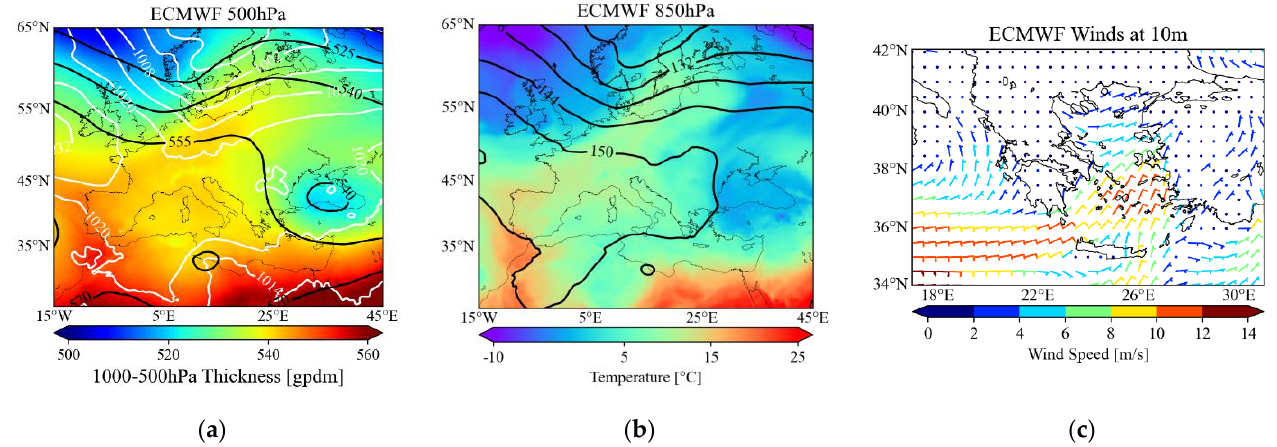
Figure 5. ECMWF Reanalysis Data for 10 April 2017, 06:00 UTC ( a ) 500 hPa Geopotential Height (black lines), MSLP (white lines), 1000 – 500 hPa Thickness, ( b ) 850 hPa Geopotential Height (black lines), 850 hPa Temperature, ( c ) 10 m Wind Speed and Direction.